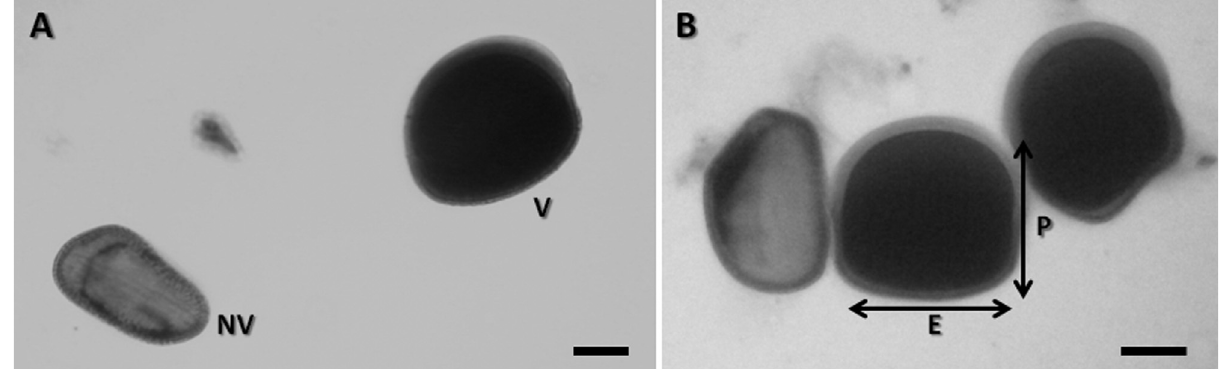
Figure5 -Pollengrainsof Calydoreacrocoides (populationESC692).A)Viable( V )andnon-viable( NV )pollengrains;BPollengrainmeasurements(P: polar axis; E: equatorial diameter). Scale bar = 10 (cid:2) Table7 -Morphologyandpollenfertilityinpopulationsof Calydoreacrocoides .Theestimatedmeasureswerepolaraxis( P ),equatorialdiameter( E ),ra- tio between polar axes ( P / E ) and percentage of viability of pollen grains (%). Population